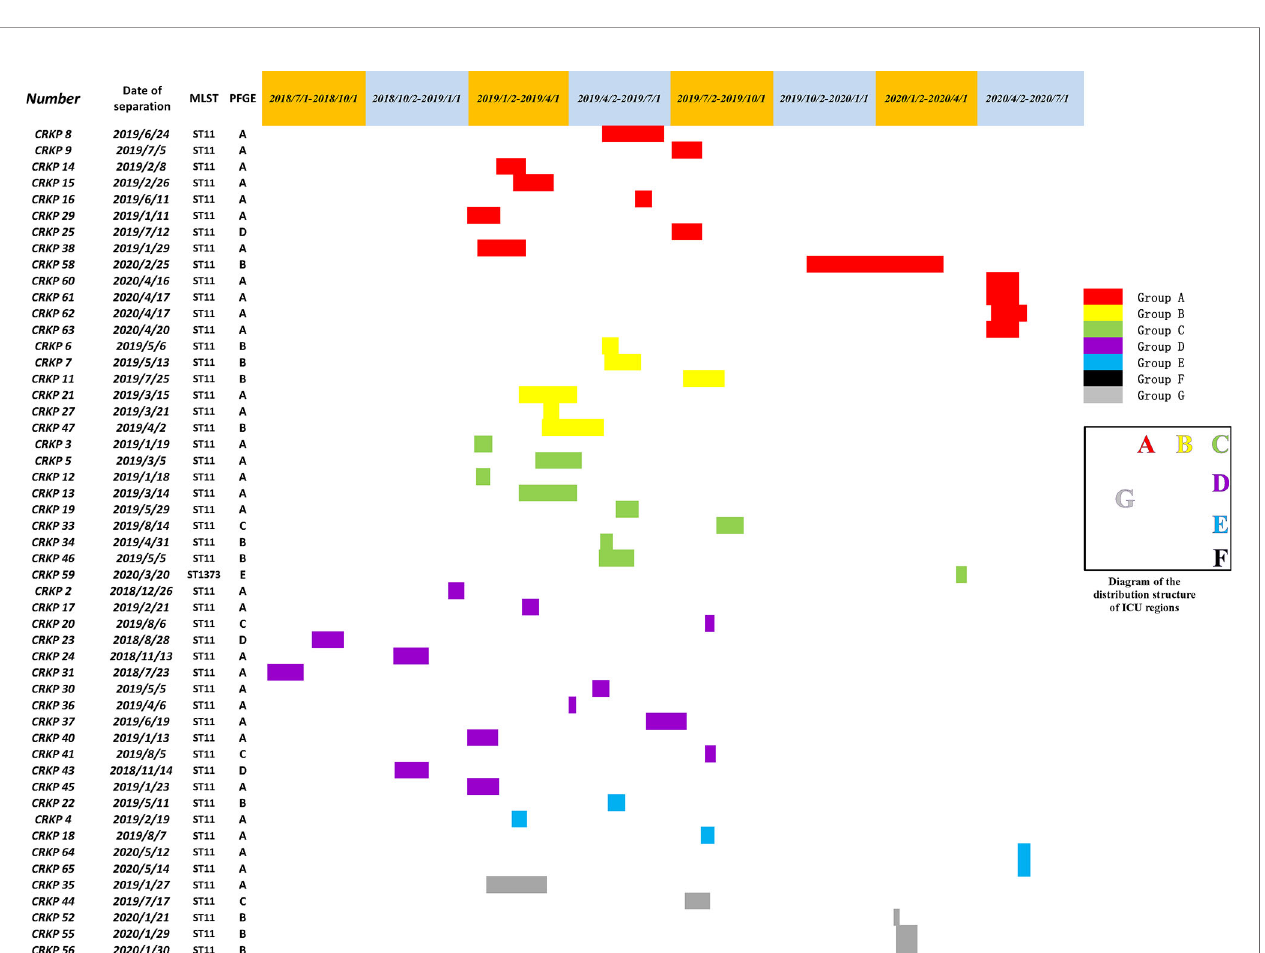
Frontiers in Cellular and Infection Microbiology |